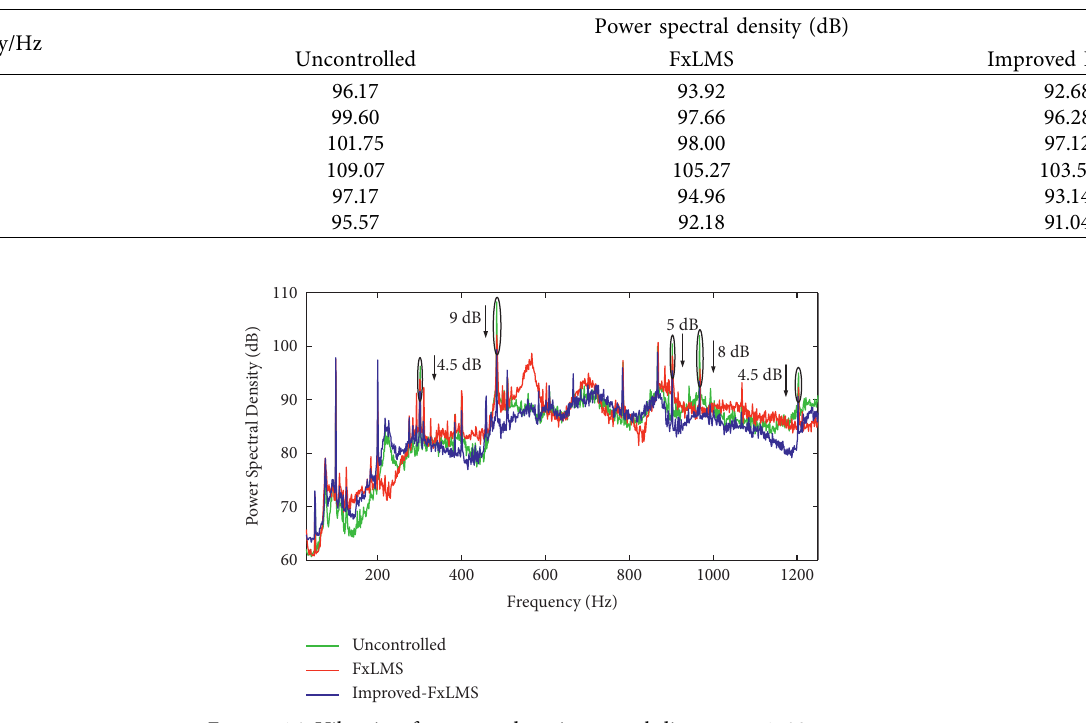
Figure 15: Vibration frequency domain control diagram at 1200rpm. Table 3: Active vibration control of the gear system at 1200r/min and 1N m.